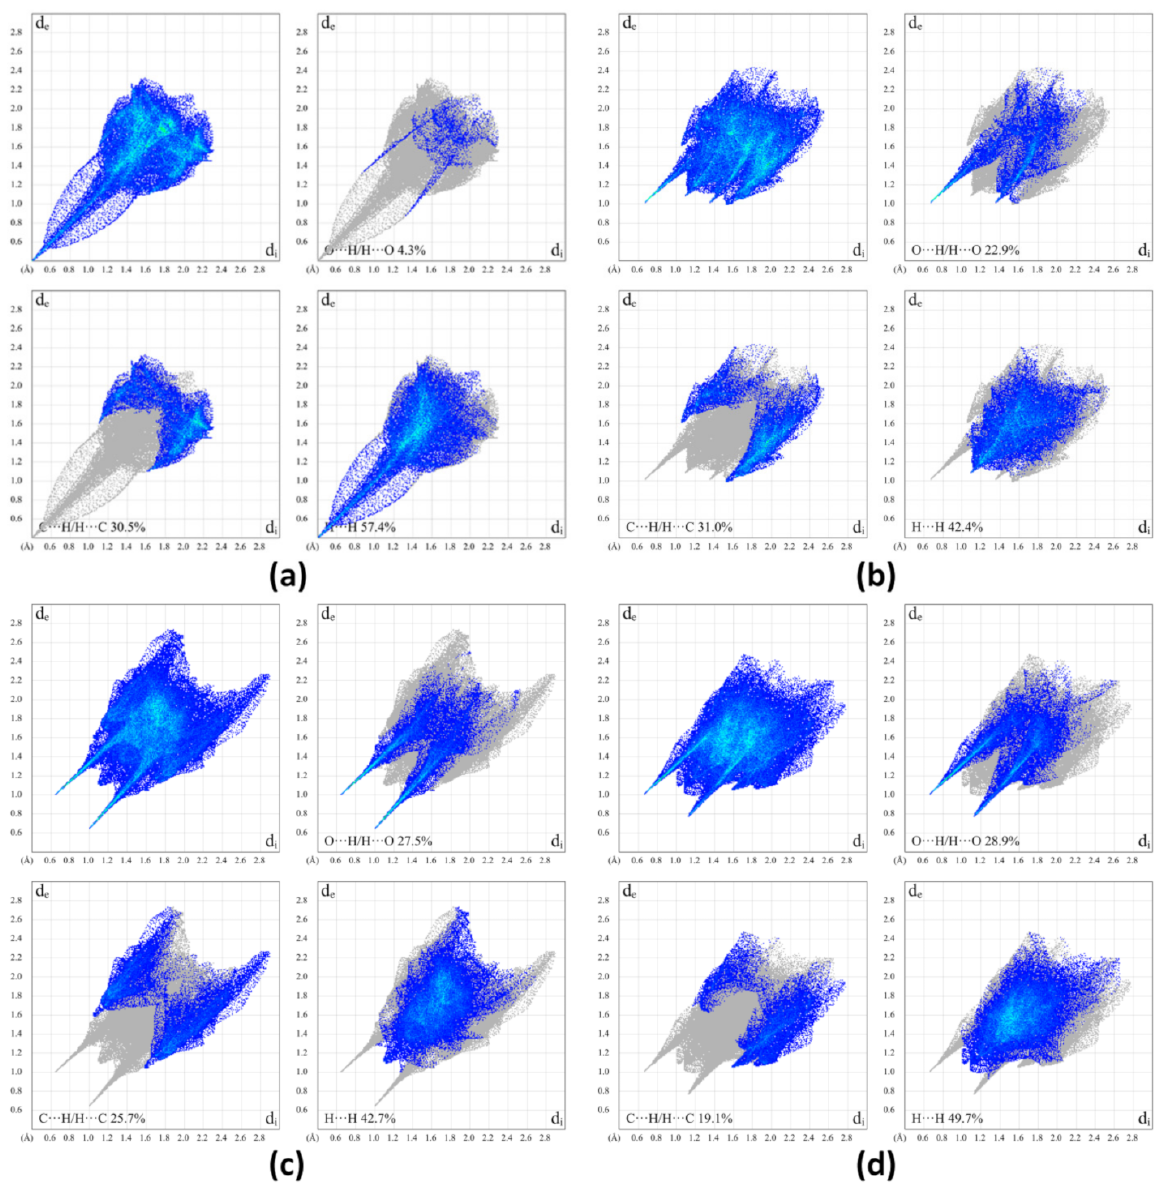
Figure 8. Two-dimensional fingerprint plots of RSV ( a ), RSV-L-Pro ( b ), PD ( c ), and PD-L-Pro ( d